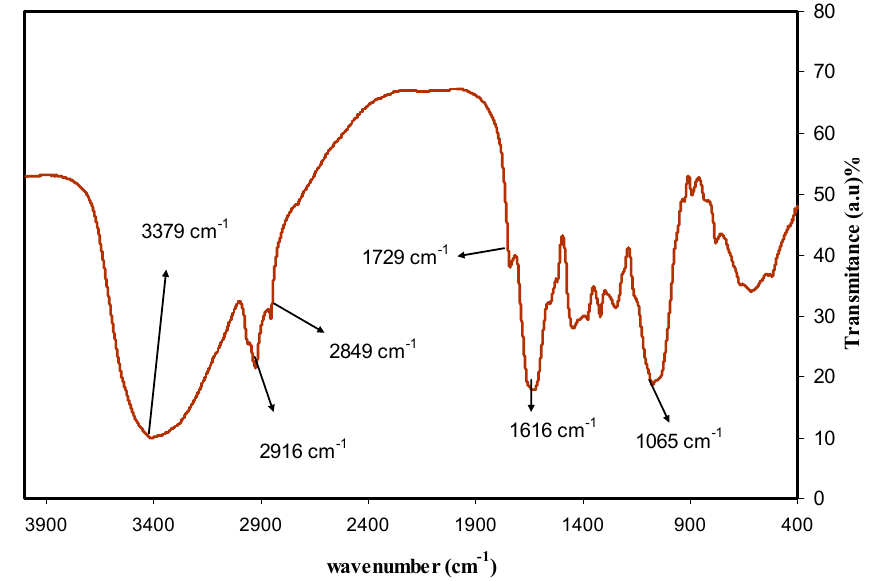
Figure 1. Spectra of pure quince Figure 1. spectra of pure quince leaves.